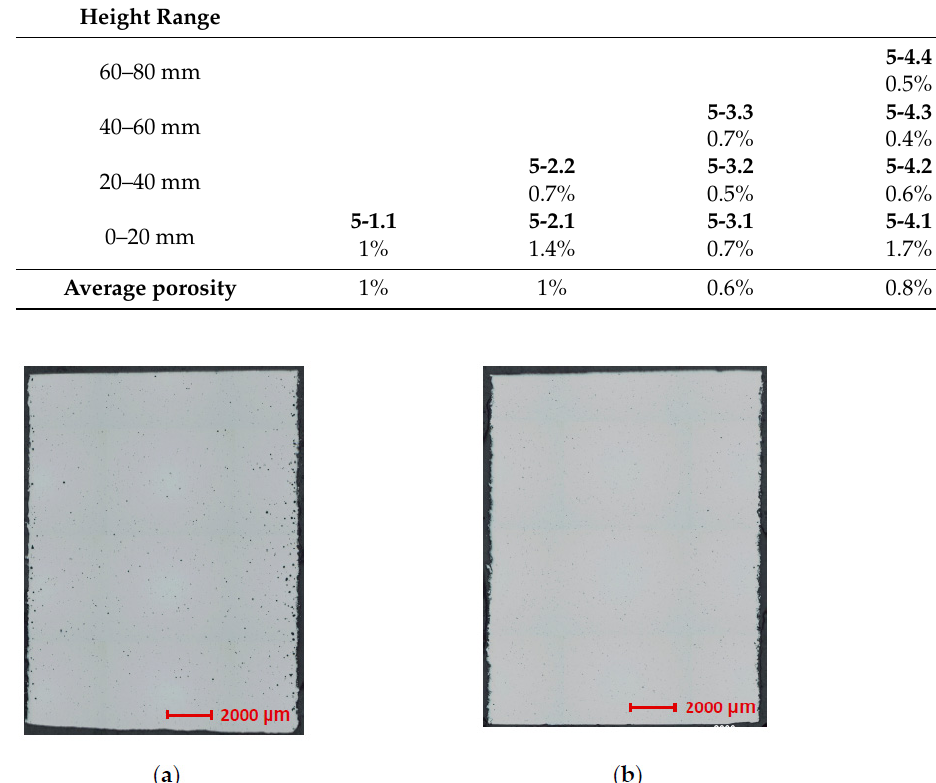
Table 6. The resulting values of the porosity of the XZ planes.